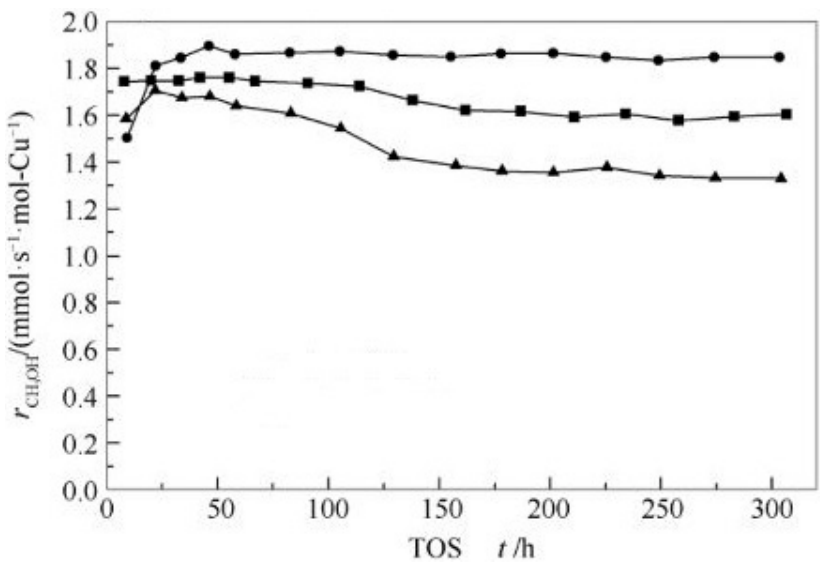
Figure 4. Methanol conversion rate as a function of time-on-stream (TOS) for the catalysts with Cu/Ni/Al molar ratio of 1/0.05/3 calcined at 900 °C (squares), 1000 °C (circles) and 1100 °C (triangles) at 255 ° C, 1 bar and WHSV = 2.18 h − 1 . Reprinted with permission from Ref. [44]. Copyright 2022 Elsevier.